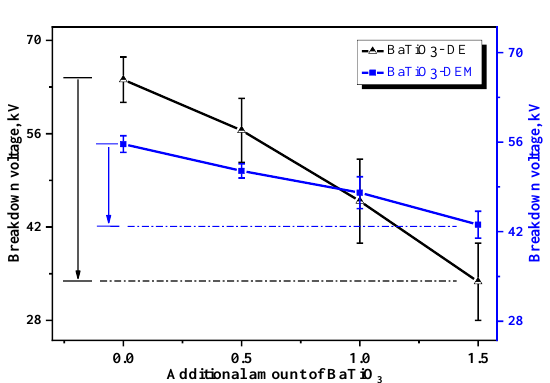
Figure 5. Comparison diagram of breakdown voltage between two kinds of samples.